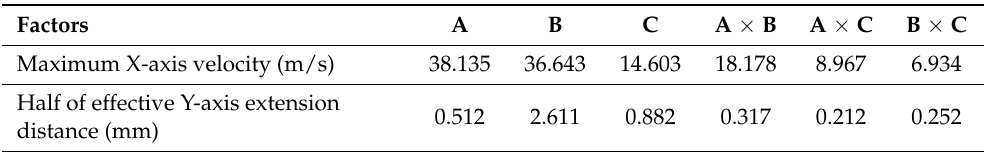
Table 5. Range analysis of the water jet